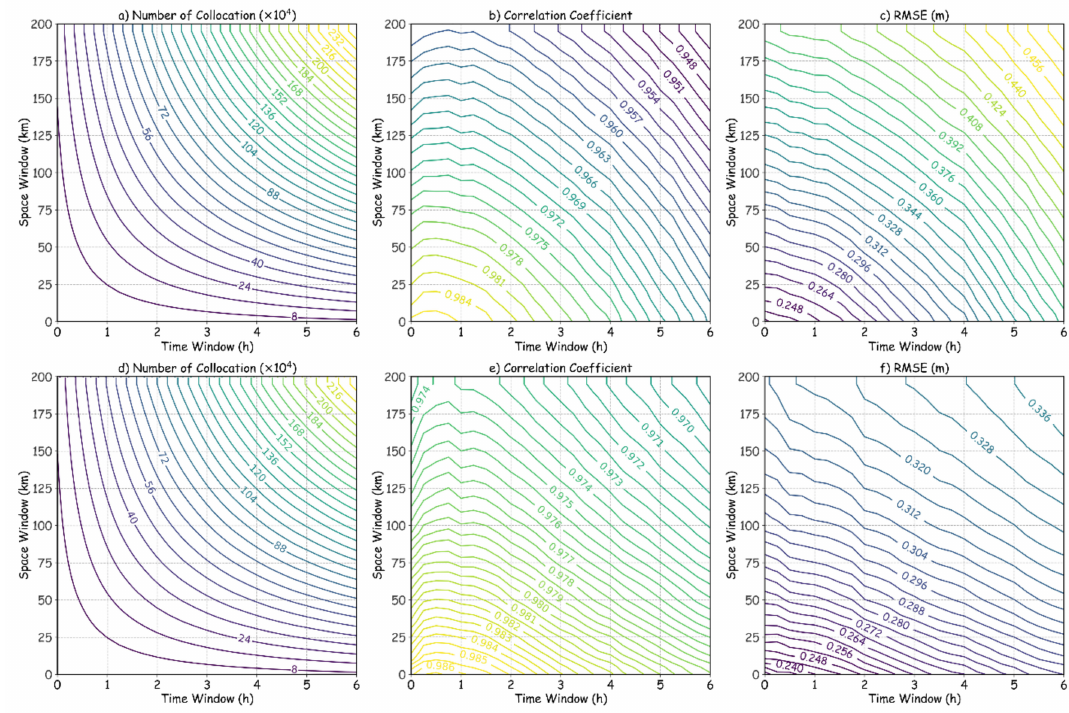
Figure 4. ( a , d ) N col , ( b , e ) CCs, and ( c , f ) RMSEs of Envisat SWHs versus Jason-1 SWHs as a function of the size of the spatial-temporal window. The upper row shows the results of direct cross-validation and the lower row shows the results of indirect cross-validation with a QC of G < 0.6 m. The color scales of the contours are identical for the same